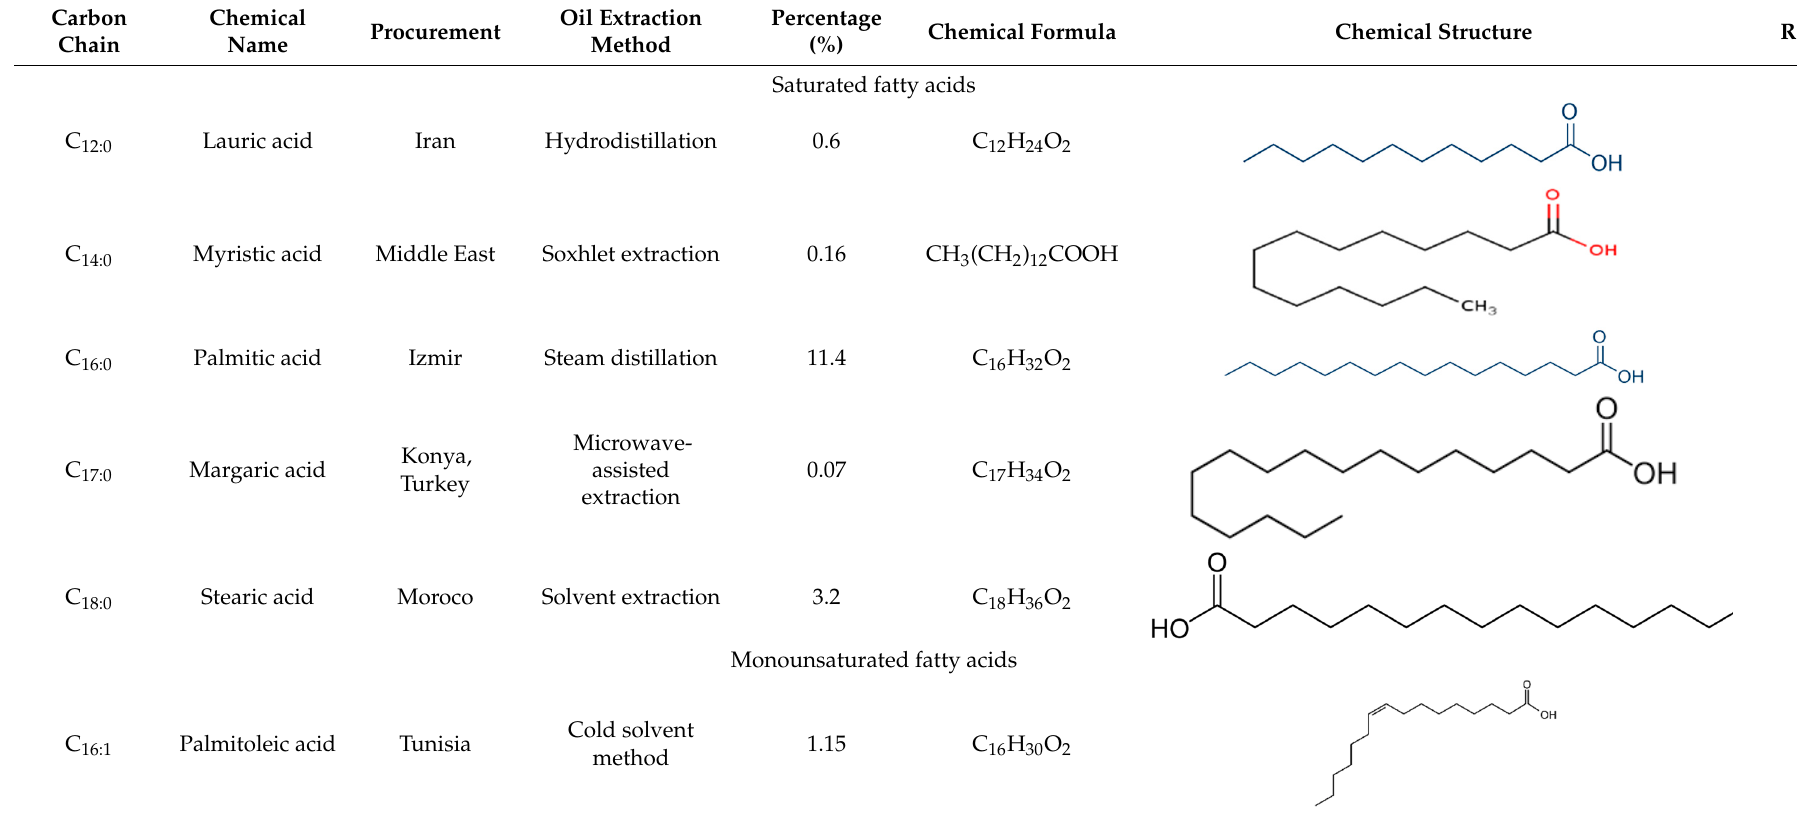
Table 2. Fatty acids profile of Nigella sativa seed